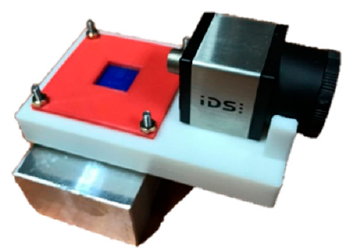
Figure 12. Experiment equipment assembled with the sensors.